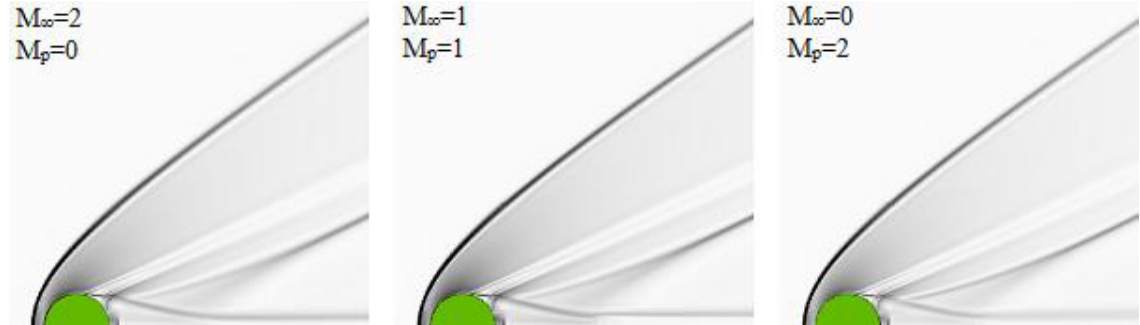
Figure 5. Shadow pattern of the flow around the sphere (single cloud of nodes).